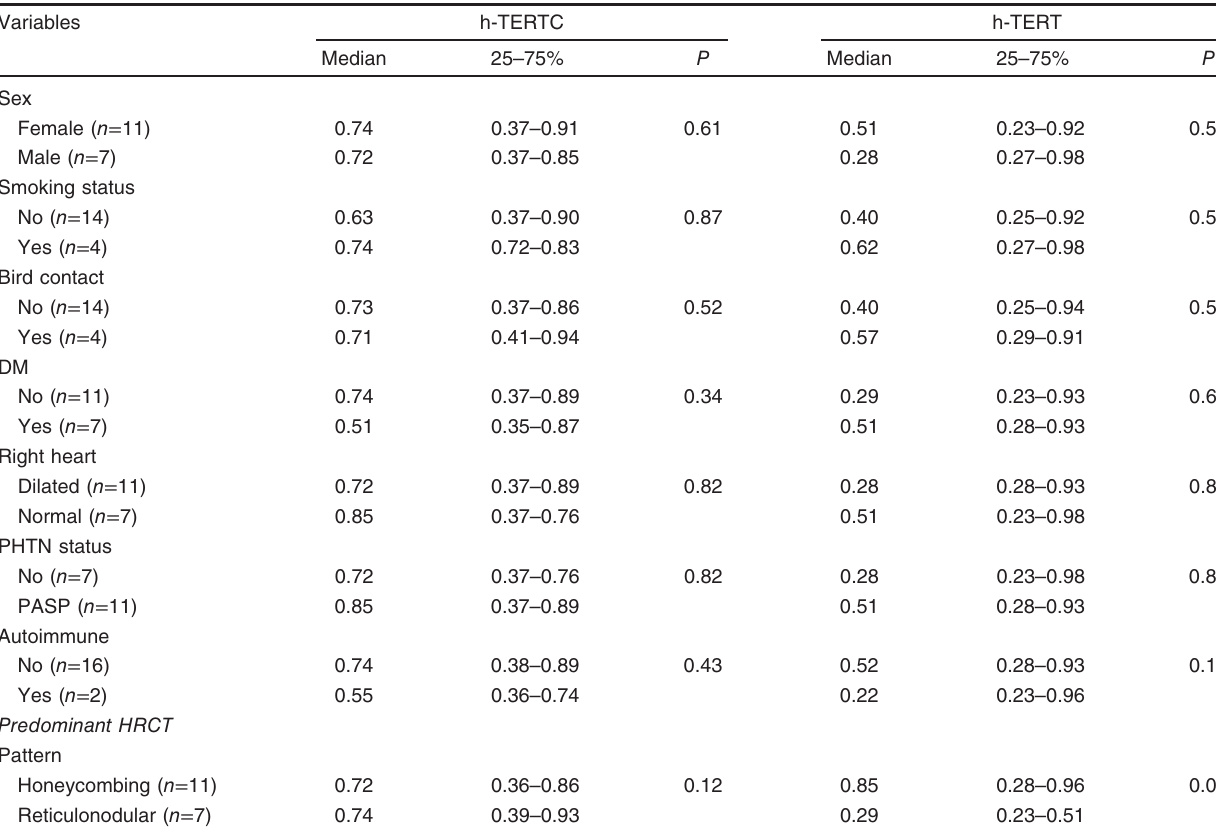
Table 5 Effect of different characteristics of patients with idiopathic pulmonary fibrosis on h-TERT and h-TERC expressions